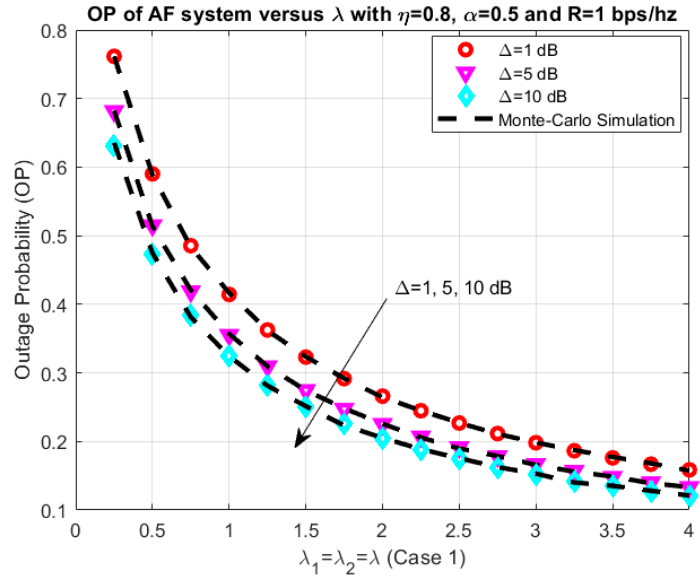
Figure 6. OP versus λ 1 = λ 2 = λ .